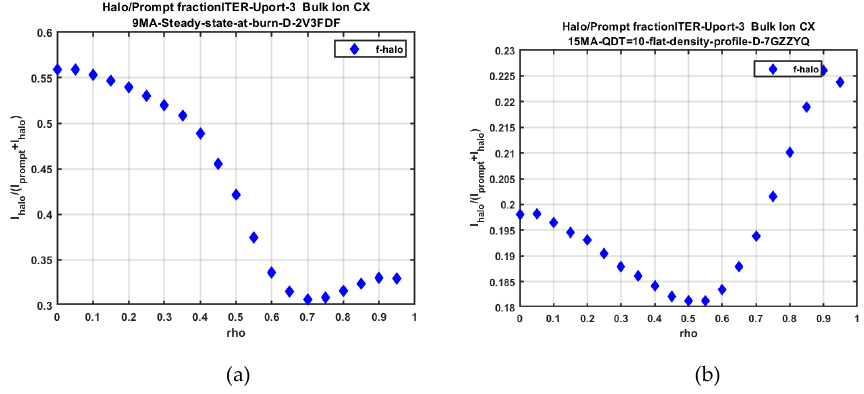
Figure 15. ( a ) Simulation of Spectra (SOS) halo-modeling of fraction I halo /(I prompt +I halo ) for D α spectrum; ( b ) SOS halo-modeling of fraction I halo /(I prompt +I halo ) for D α spectrum.